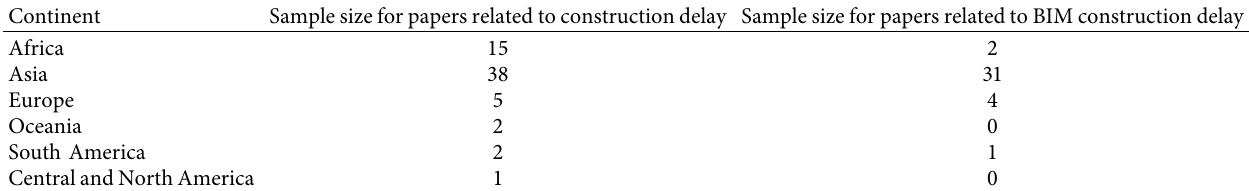
Table 3: Sample sizes for papers related to construction delay and BIM construction delay.